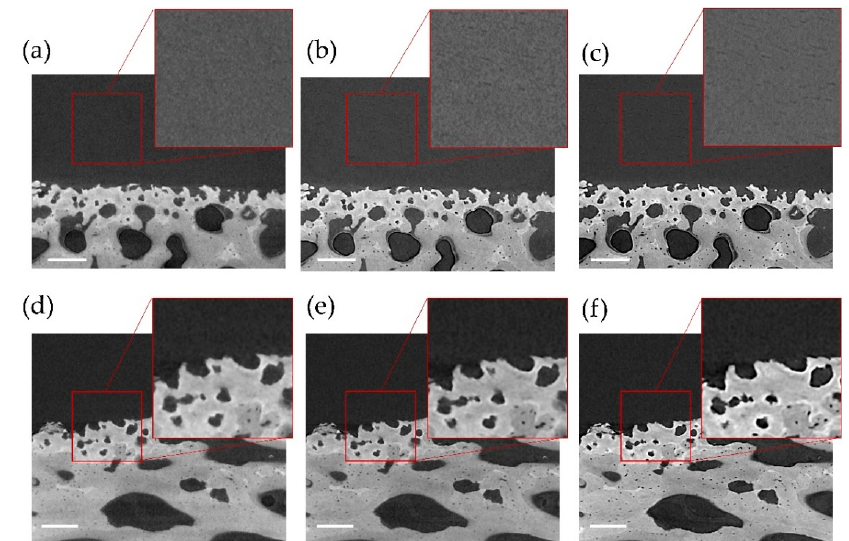
Figure 2. XCT cross-sections of specimens ( a – c ) CB1, kept moist throughout imaging and ( d – f ) CB4, kept in PBS at increasing propagation distances: ( a , d ) absorption, ( e ) 2×, ( b ) 3× and ( c , f ) 4× propagation distance for phase-contrast imaging. Details of ( a , c ) chondrocyte lacunae and ( d , f ) bone-cartilage interface are also shown. Scale bars are 200 µm for all images.